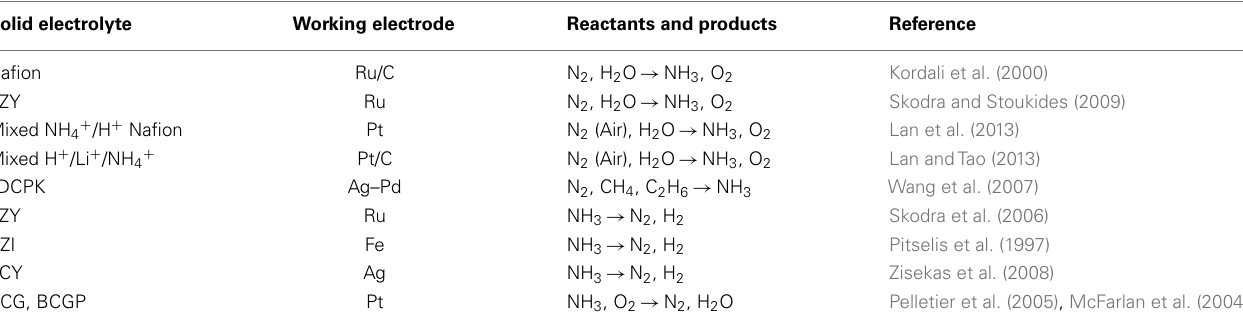
Table 2 |The reactants and products formed in electrochemical ammonia synthesis and ammonia utilization cells using alternative hydrogen sources.